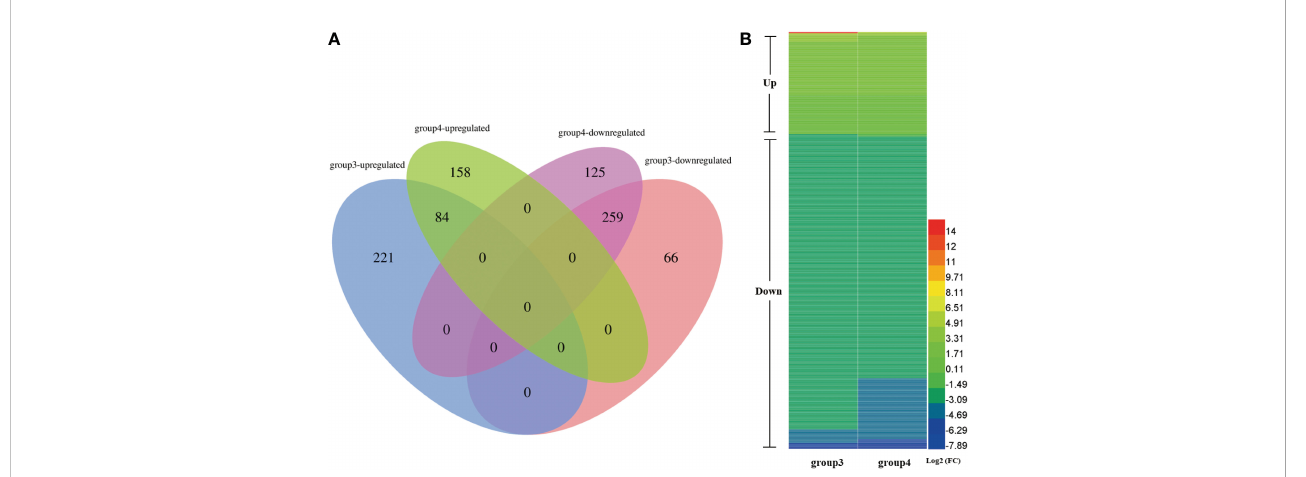
FIGURE 4 Expression patterns of differentially expressed proteins (DEPs) in W931A at the uninucleate microspore (UM) and binucleate pollen (BP) stages. (A) Venn diagram showing unique and overlapping DEPs in W931A at the UM and BP stages (group3 and group4, respectively). (B) There were 343 DEPs shared between the UM and BP